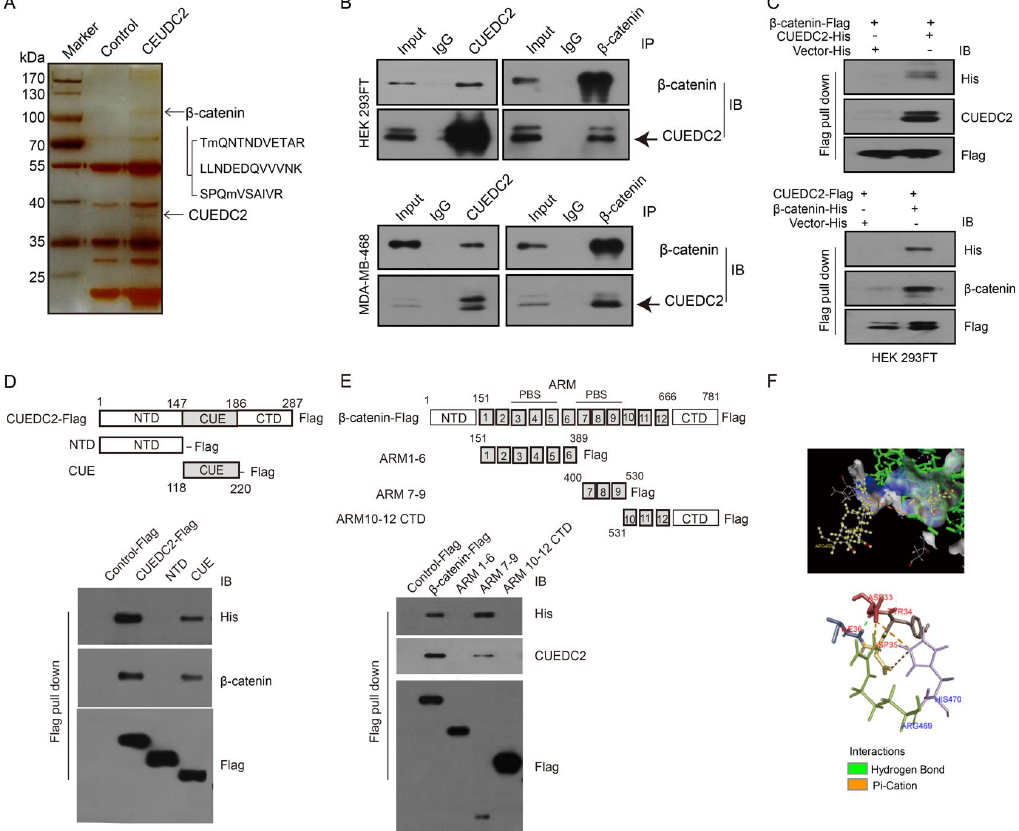
Figure 3. CUEDC2 directly interacts with β -catenin. ( A ) HEK-293FT cells were transfected with CUEDC2 or a control plasmid. Cell extracts were immunoprecipitated with an anti-CUEDC2 antibody. The immunoprecipitated proteins were analyzed using LC-MS/MS. Three peptide sequences of β -catenin were identified. ( B ) Upper panel: Exogenous Co-IP of CUEDC2 and β -catenin in the proteins from HEK-293FT cells with over-expressed CUEDC2 ( Left ) or β -catenin ( Right ). Lower panel: Endogenous Co-IP of CUEDC2 and β -catenin in the proteins from MDA-MB-468 cells with basal expression of CUEDC2 and β -catenin. ( C ) Flag pull-down was performed using purified β - catenin-Flag and CUEDC2-His ( up panel ) or CUEDC2-Flag and β -catenin-His ( low panel ), followed by immunoblotting (IB) with antibodies against His, CUEDC2, β -catenin or Flag. ( D ) Flag pull- down was performed using purified CUEDC2-Flag or Flag-labeled domains of CUEDC2 (NTD-Flag, CUE-Flag) and 6 × His- β -catenin, followed by IB with antibodies against His, β -catenin, or Flag. ( E ) Flag pull-down was performed using purified β -catenin-Flag or Flag-labeled domains of β -catenin (ARM1-6-Flag, ARM7-9-Flag, or ARM10-12 CTD-Flag) and 6 × His-CUEDC2, followed by IB with antibodies against His, CUEDC2 or Flag. ( F ) Combination sites of CUEDC2 and β -catenin predicted by PyMOL. Data are representative of three independent